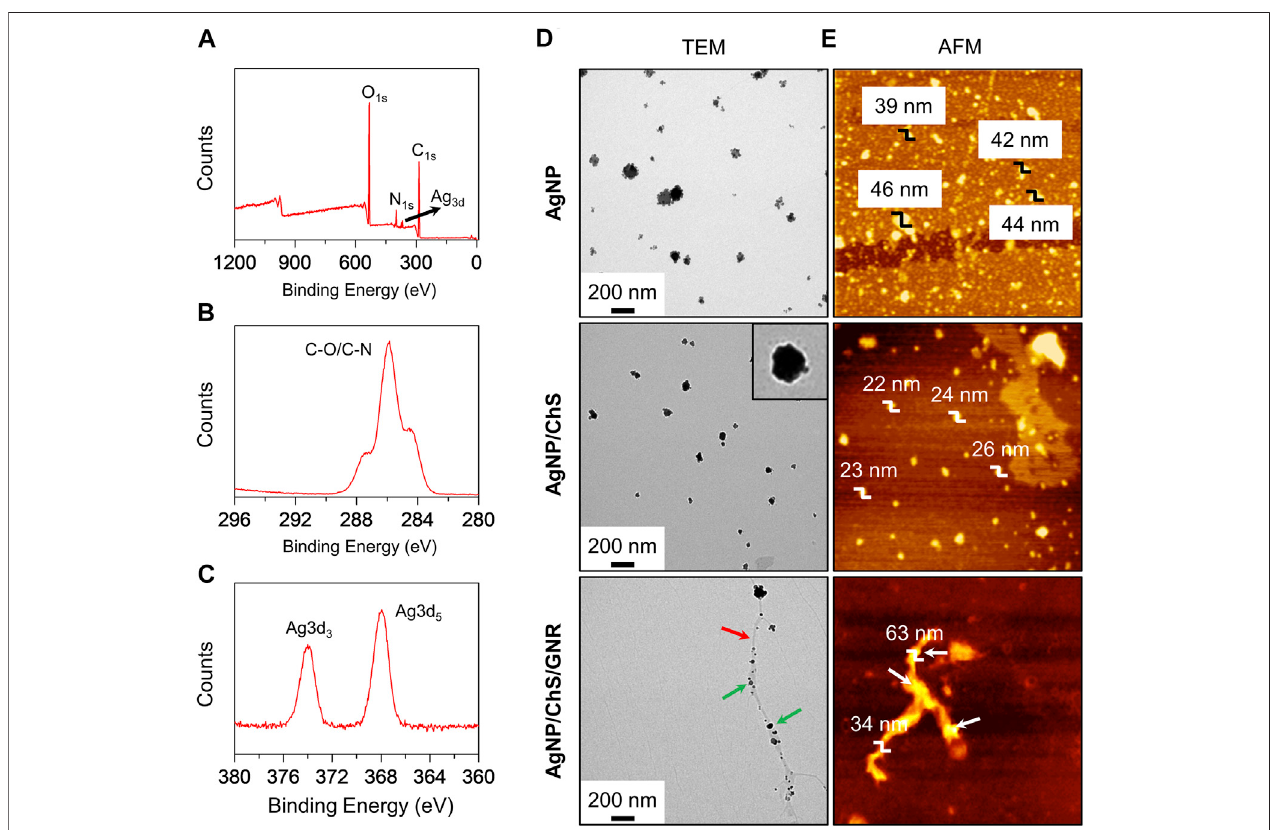
FIGURE 1 | (A) Wide-scan XPS spectrum of AgNP/ChS (10 μ g ml − 1 /2 mg ml − 1 ) corresponding to the characteristic peaks of elemental N, C, O, Ag. (B) X-ray photoelectronspectroscopy(XPS)ofAgNP/ChS(10 μ g ml − 1 /2 mg ml − 1 )correspondingtothecharacteristicpeaksofC-OandC-N. (C) XPSofAgNP/ChS(10 μ g ml − 1 / 2 mg ml − 1 ) corresponding to the characteristic peaks of Ag3d. (D) Transmission Electron Microscope (TEM) and (E) Atom Force Microscope (AFM) images of AgNP (10 μ g ml − 1 ),AgNP/ChS (10 μ g ml − 1 /2 mg ml − 1 ),and AgNP/ChS/GNR (10 μ g ml − 1 /2 mg ml − 1 /20 μ g ml − 1 ). The red and green arrows in the TEM image ofAgNP/ ChS/GNR indicate GNR nanowire and AgNP/ChS,